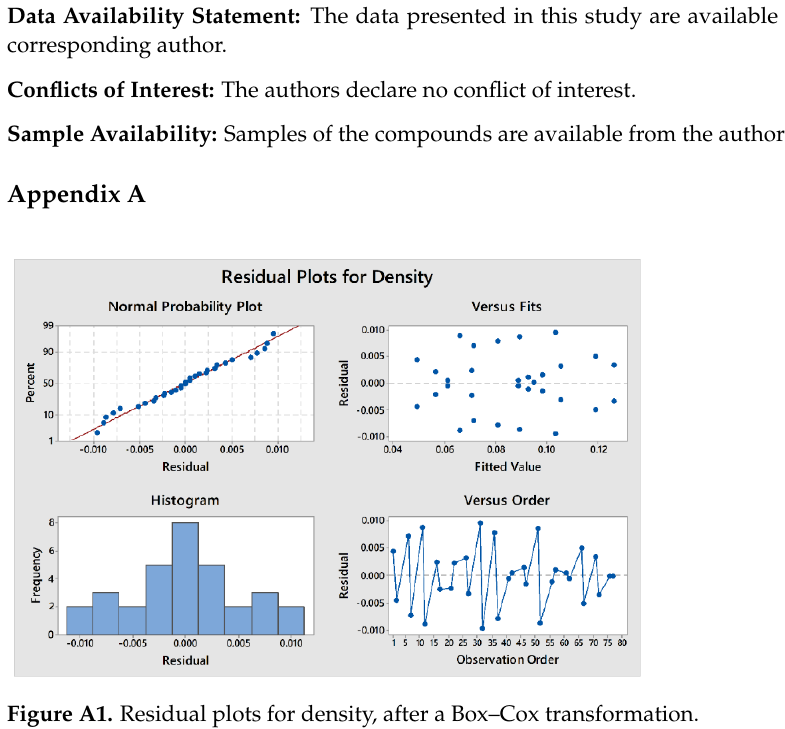
Figure A1. Residual plots for density, after a Box–Cox transformation.